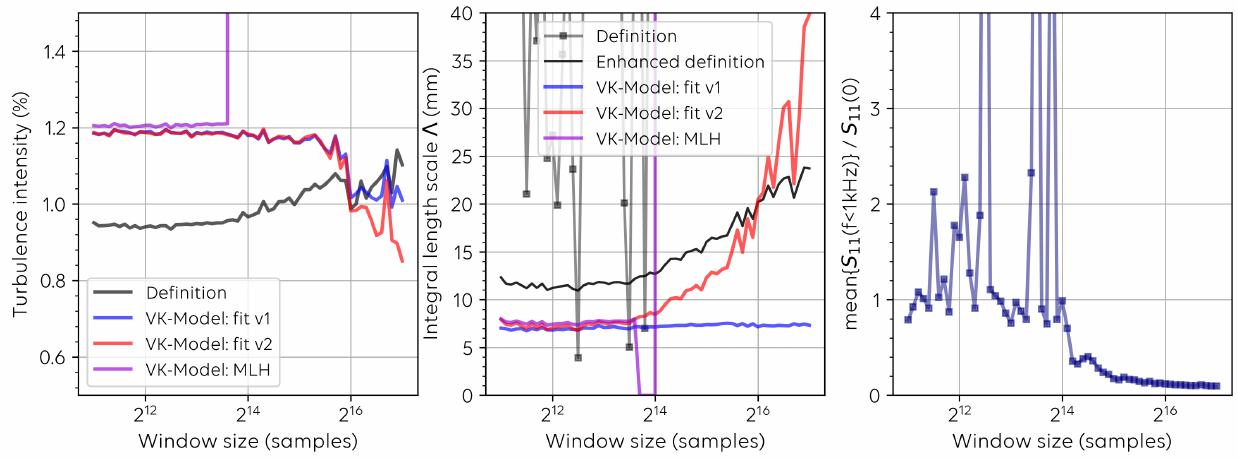
Figure 9. The impact of Window size on the results obtained for each turbulence parameter estimation technique. For this illustration, the longitudinal velocity component was selected. Data from the same hot-wire measurement point as shown in Figure